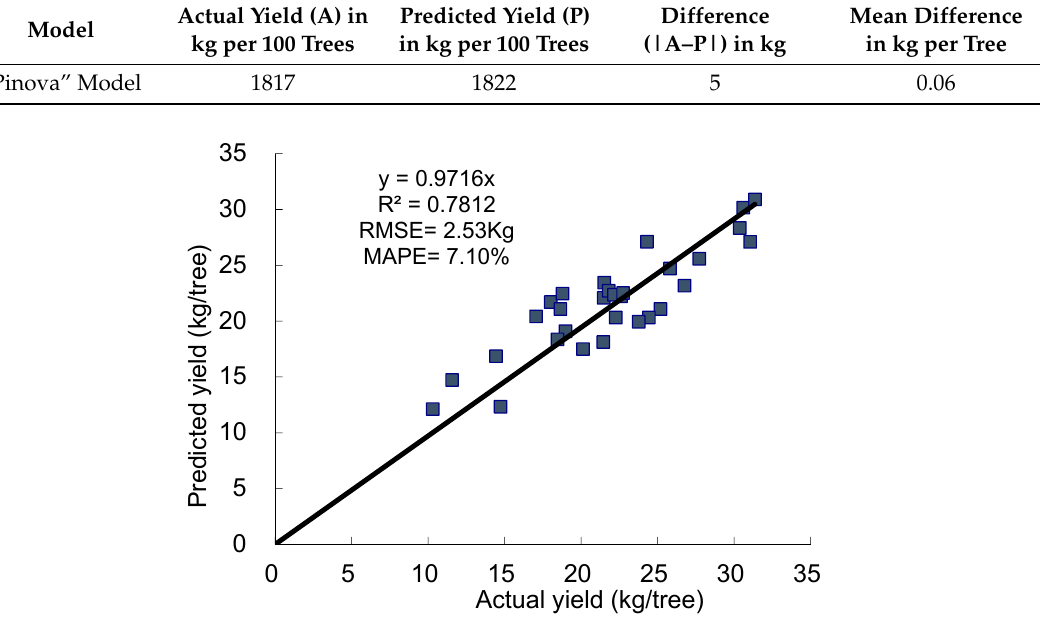
Figure 7. Yield prediction for 2013 based on the prediction “Pinova” Model for young apple fruit in July for the subsequent year ( n = 34 trees).